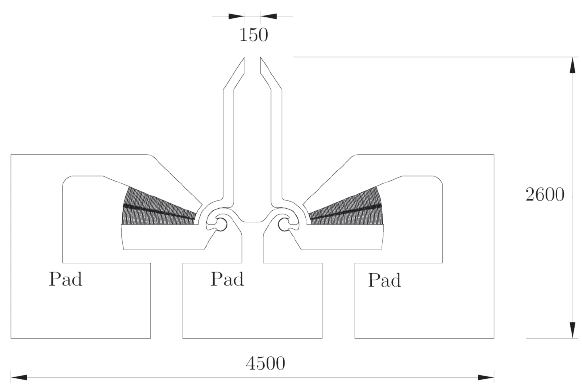
Figure 1. Mask corresponding to the conjugate surfaces flexure hinge (CSFH) microgripper, pads and overall dimensions ( µ